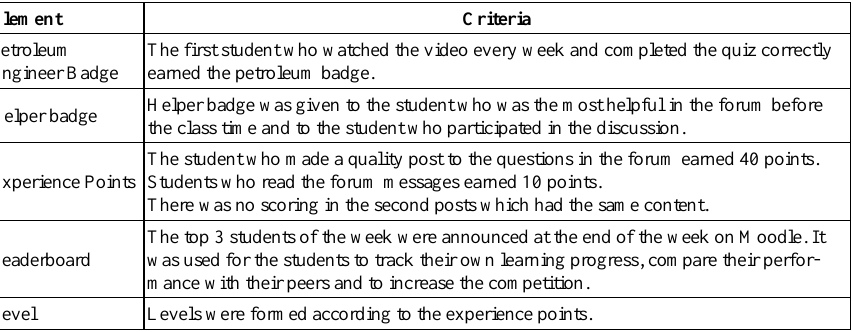
Table 4. Gamification elements used in the